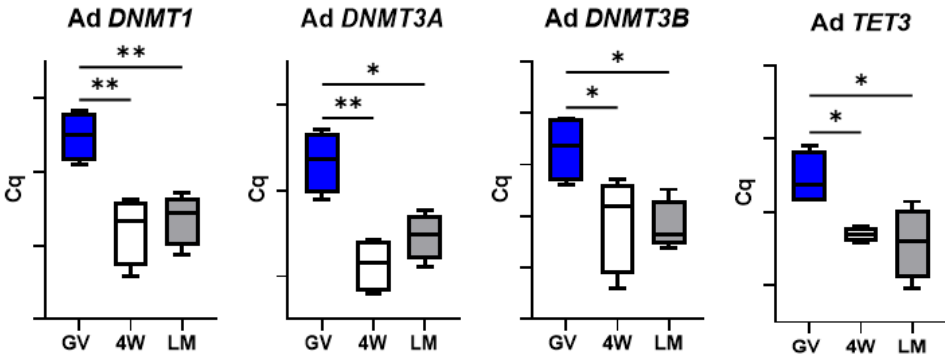
Figure 9. Expression of genes involved in DNA methylation reprogramming in pools of adult GV and MII oocytes matured in 4-well plates (4W) or in liquid marbles (LM). Target gene expression was normalized against the luciferase exogenous control. Relative abundance is expressed as ∆ Cq ( Y -axis). Each box represents the mean expression of 5 replicate pools of 10 oocytes each (mean ± SE). Significant differences were assessed by ANOVA general linear model test; * p < 0.05, ** p < 0.01.